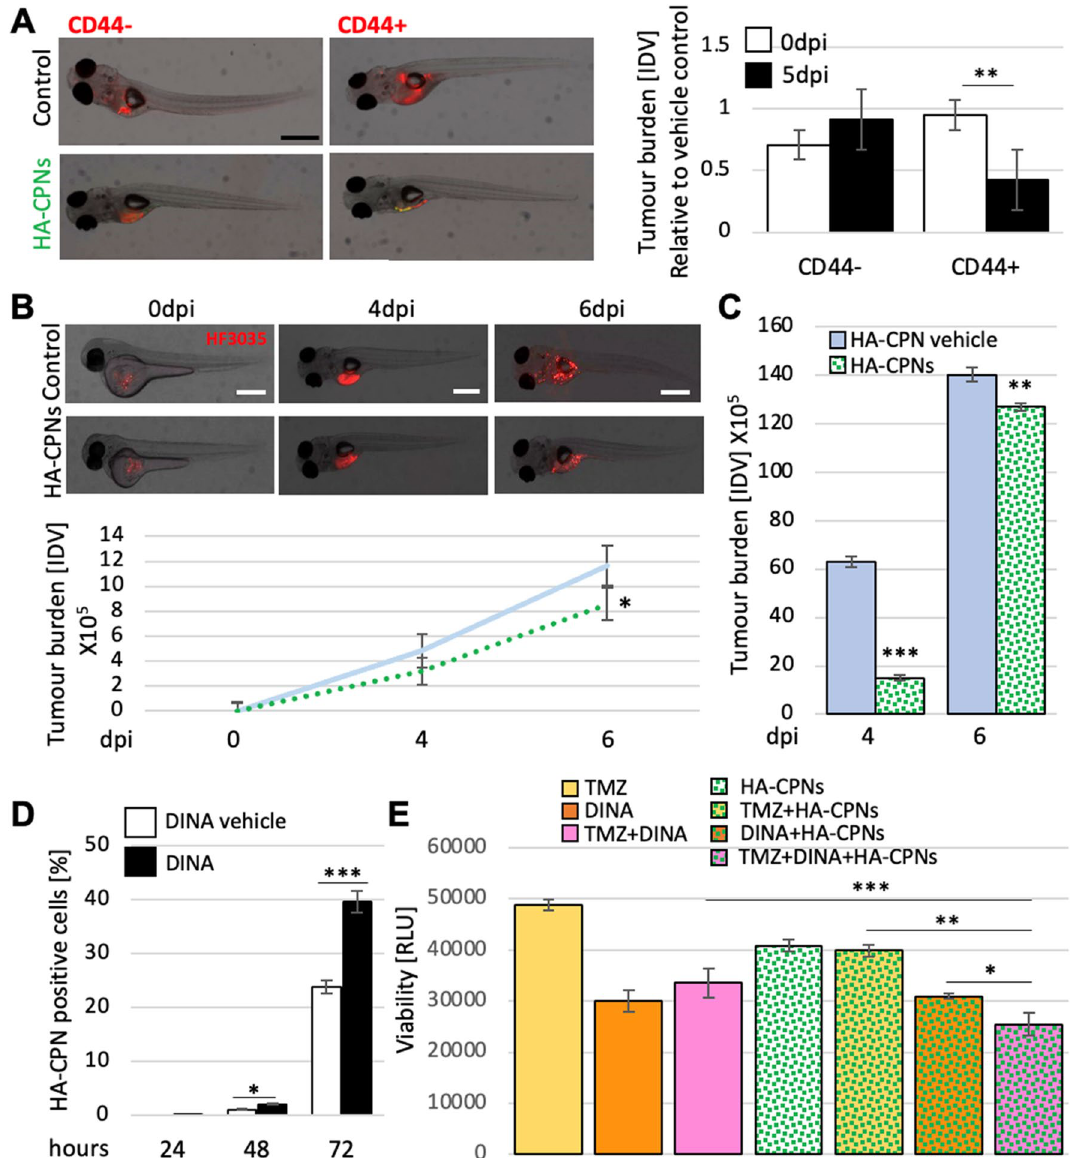
Figure 6. Decrease of Tumour Burden in GBM Zebrafish PDXs and Enhanced Treatment Sensitivity upon Exposure to HA-CPNs. ( A ) Representative image (left) and tumour foci burden analysis (right) in zebrafish embryos injected with fluorescently labelled (red) CD44 + and/or CD44- cells and analysed at 0- and 5-days post injection. Tumour burden quantified and graphed as Integrated Density Values (IDV) for HA- CPN treatment/ HA-CPN vehicle control treatment (Control) at the indicated time points; ( B ) HF3035 and HF2303 GBM patient-derived zebrafish PDX models treated with HA-CPNs compared to HA-CPN vehicle control; representative images of PDX using HF3035 (top) and average tumour burden quantified using ImageJ as IDV at the indicated timepoints (bottom) over two GBM patient lines; ( C ) Average tumour burden quantification at the indicated timepoints in PDXs derived from CD44 + HF3035 and CD44 + HF2303 GBM lines treated with HA-CPNs compared to HA-CPN vehicle control (Control) over time; ( D ) Cells treated with dinaciclib and/or vehicle control (Control) in the presence of 24 HA-CPNs/cell. Nanoparticle uptake analysed using flowcytometry at the indicated time points; ( E ) Cell viability quantified using a luminescent assay at 72 h post HA-CPN and drug treatment, as monotherapy or in combination as indicated (TMZ, Temozolomide; DINA, dinaciclib). Data shown as mean ± s.d, n = 3, *p < 0.05, **p < 0.01, ***p < 0.001; Student’s t